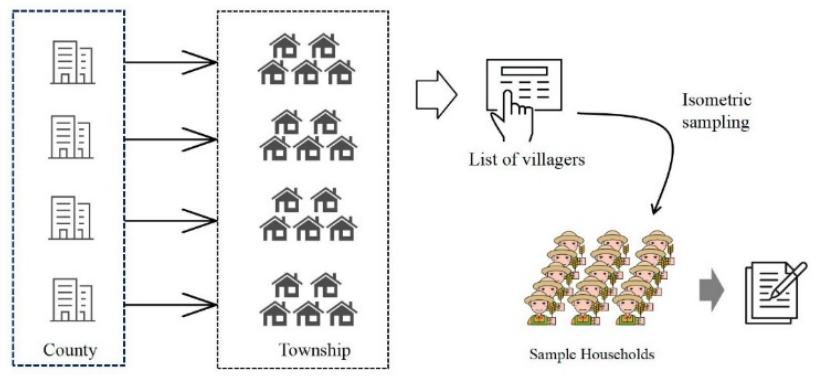
Figure 3. Illustration of stratified sampling.